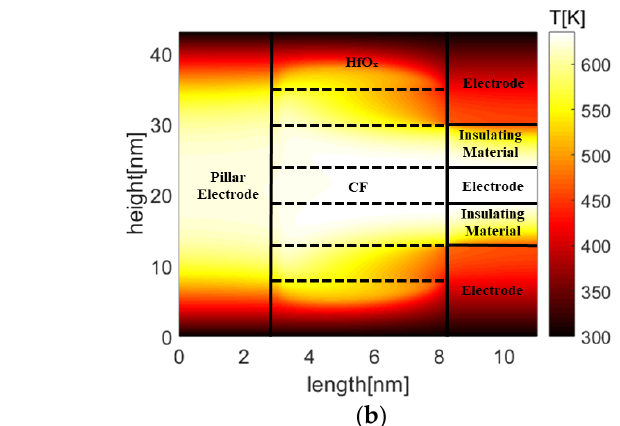
( b ) Figure 5. Oxygen vacancy density distributions for the ( a ) GE-RRAM and ( b ) Pt-RRAM, in which both the top and bottom cells are active, and captured at 0 s. Figure 6 presents the oxygen vacancy density and temperature distributions in Pt- RRAM. The depletion layer has formed in the middle conduction filament of the inactive cell in Figure 6a, since the inactive cell was affected by the adjacent active cells. This may lead to the change of logic state and device failure. Due to the crosstalk effect from the adjacent active cells, the temperature of the inactive cell has reached 632 K. The tempera- ture of active cells increases rapidly due to the Joule heating effect during the reset pro- cess. A depletion layer is gradually formed in the conduction filament of the active cells, leading to the increment of cell resistance. The initial high temperature region locates around the conduction filament of the active cells, since the larger current density. As the heat accumulates and the conduction filament breaks, parts of the heat transfer from above and below active cells to the middle inactive cell, which raise temperature in the